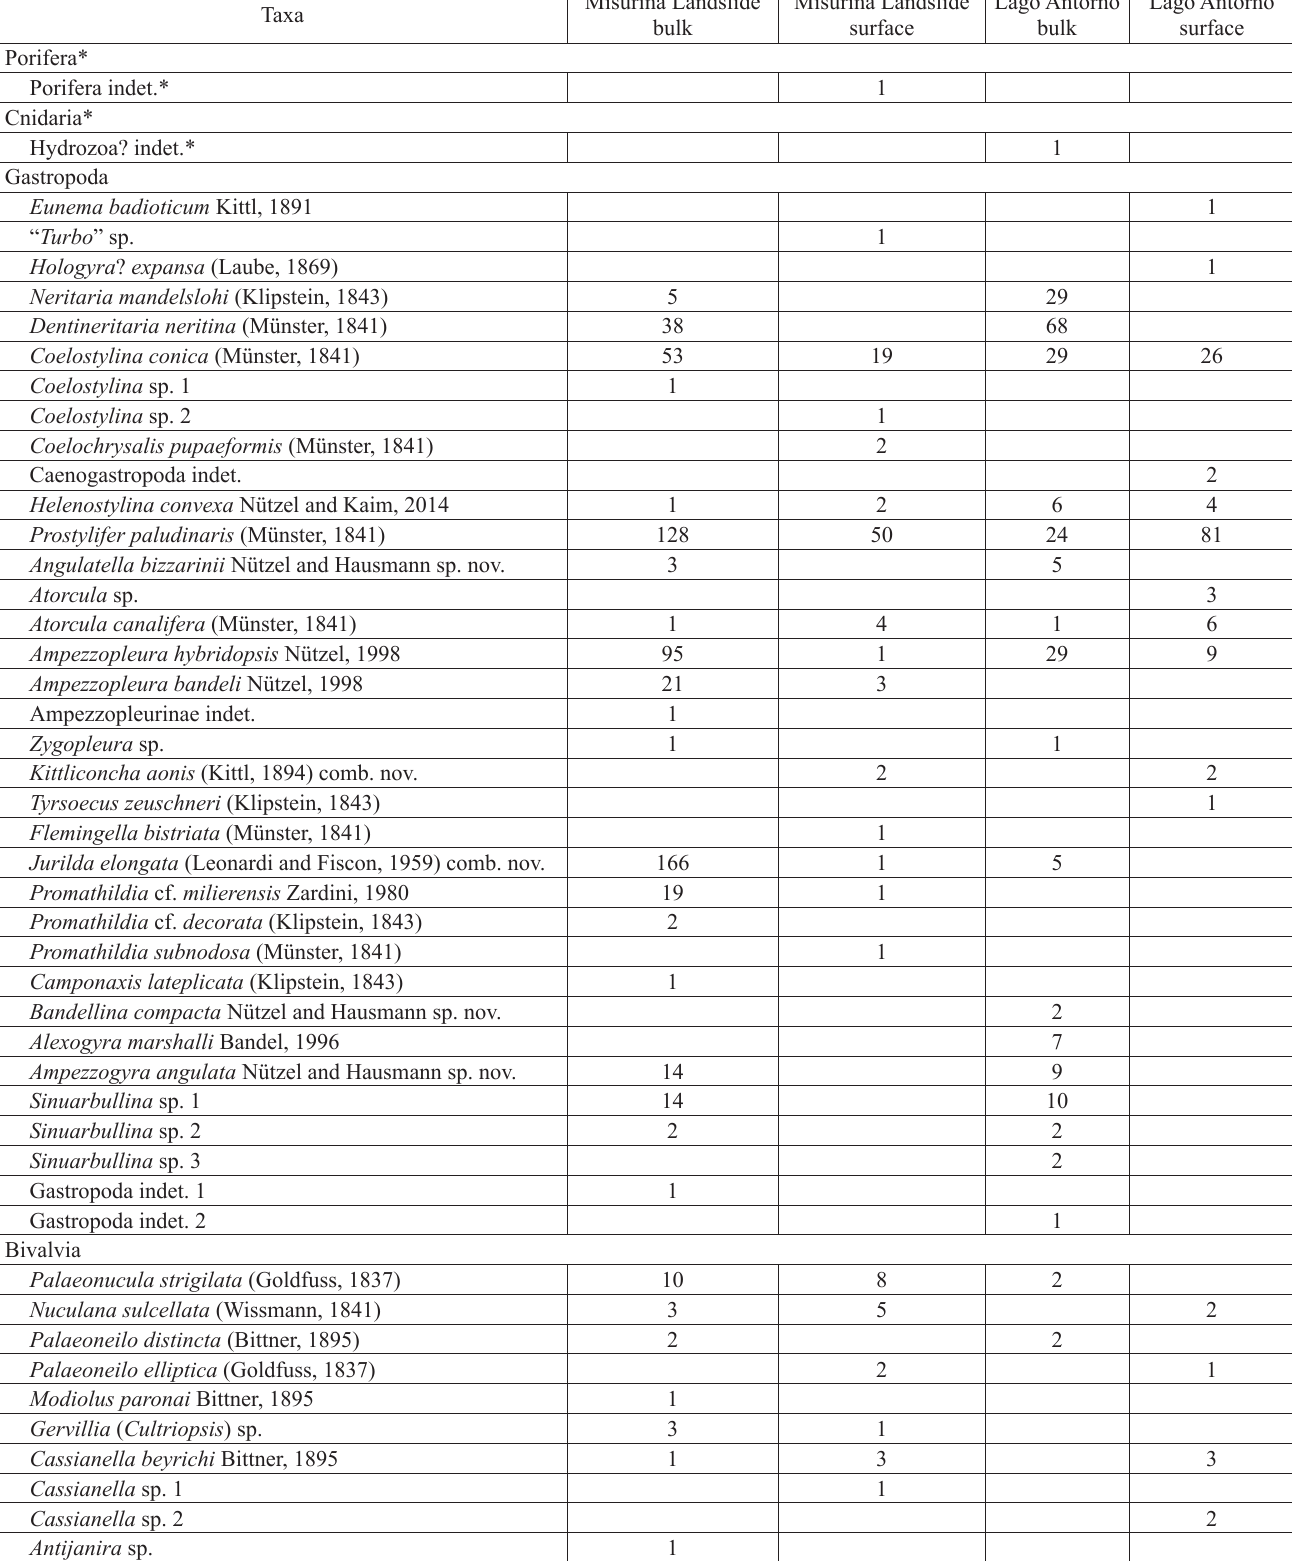
Table 1. Species and abundances lists of the bulk and surface collections from Misurina Landslide and Lago Antorno. * not included in statistical analyses because of allochthonous origin and therefore not being part of the original palaeocommunity; ** not included in statistical analyses because size fraction was <0.5